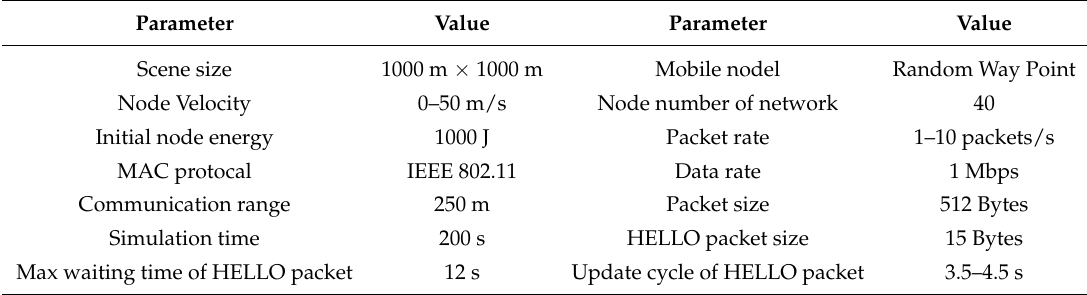
Table 1. Simulation